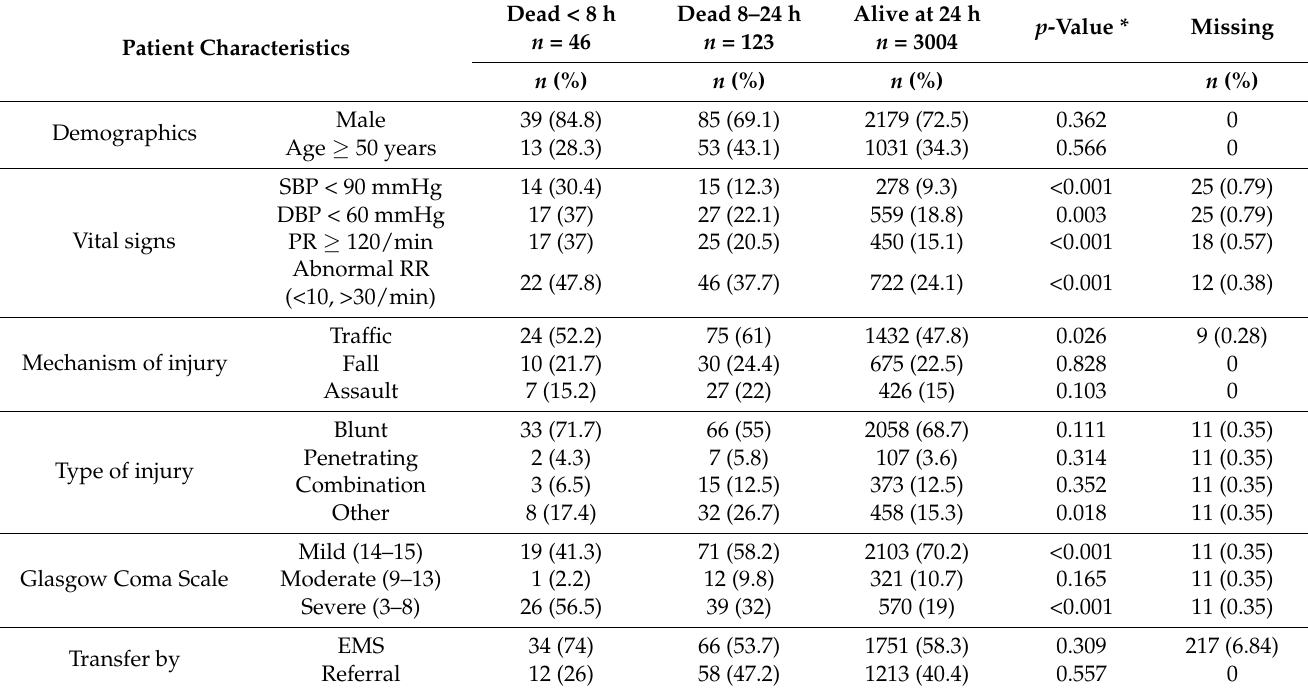
Table 1. Characteristics of patients with major trauma, criterion-classified into three levels of severity.